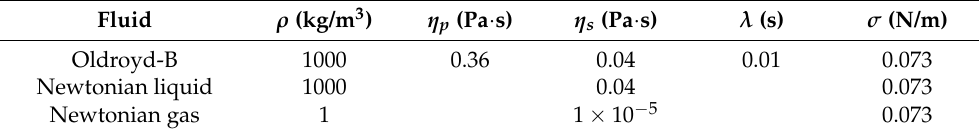
Table 1. Liquid properties